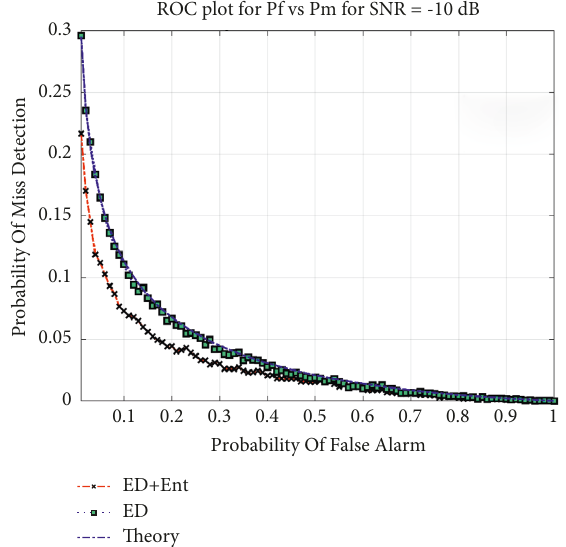
Figure 8: P f vs. P m at SNR